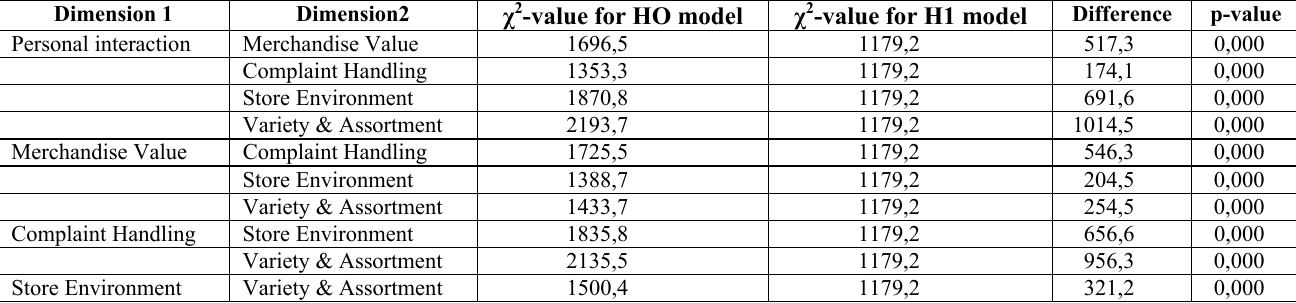
Table 13: Discriminant validity between individual dimensions: Sample 1 Dimension 1